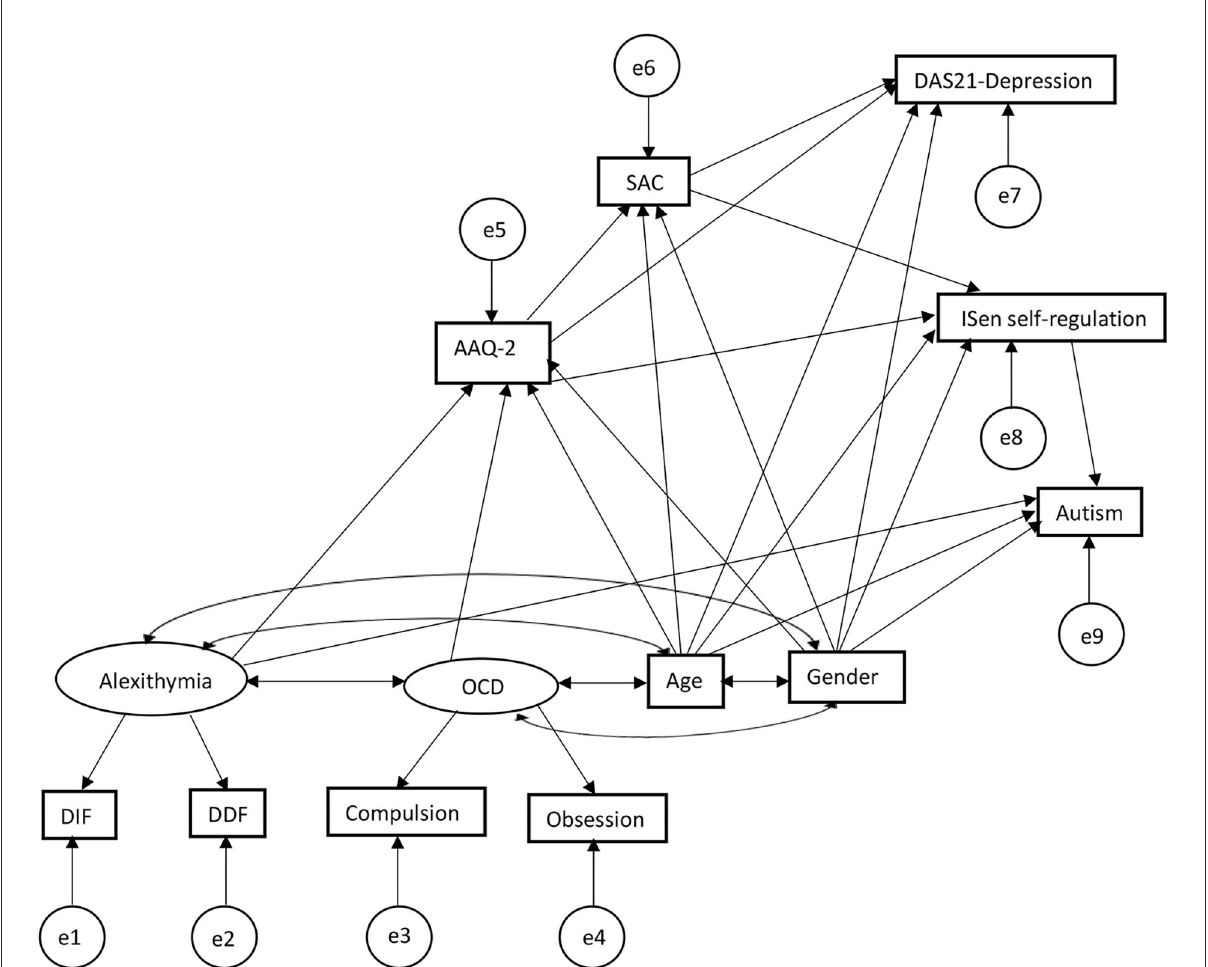
FIGURE3 SEM second output extended the first SEM in Figure 2 adding SAC and depression scale, showing a second and third mediation of SAC mediating the relationship between AAQ-2 and ISen self-regulation, and the relation between AAQ-2 and DAS-21